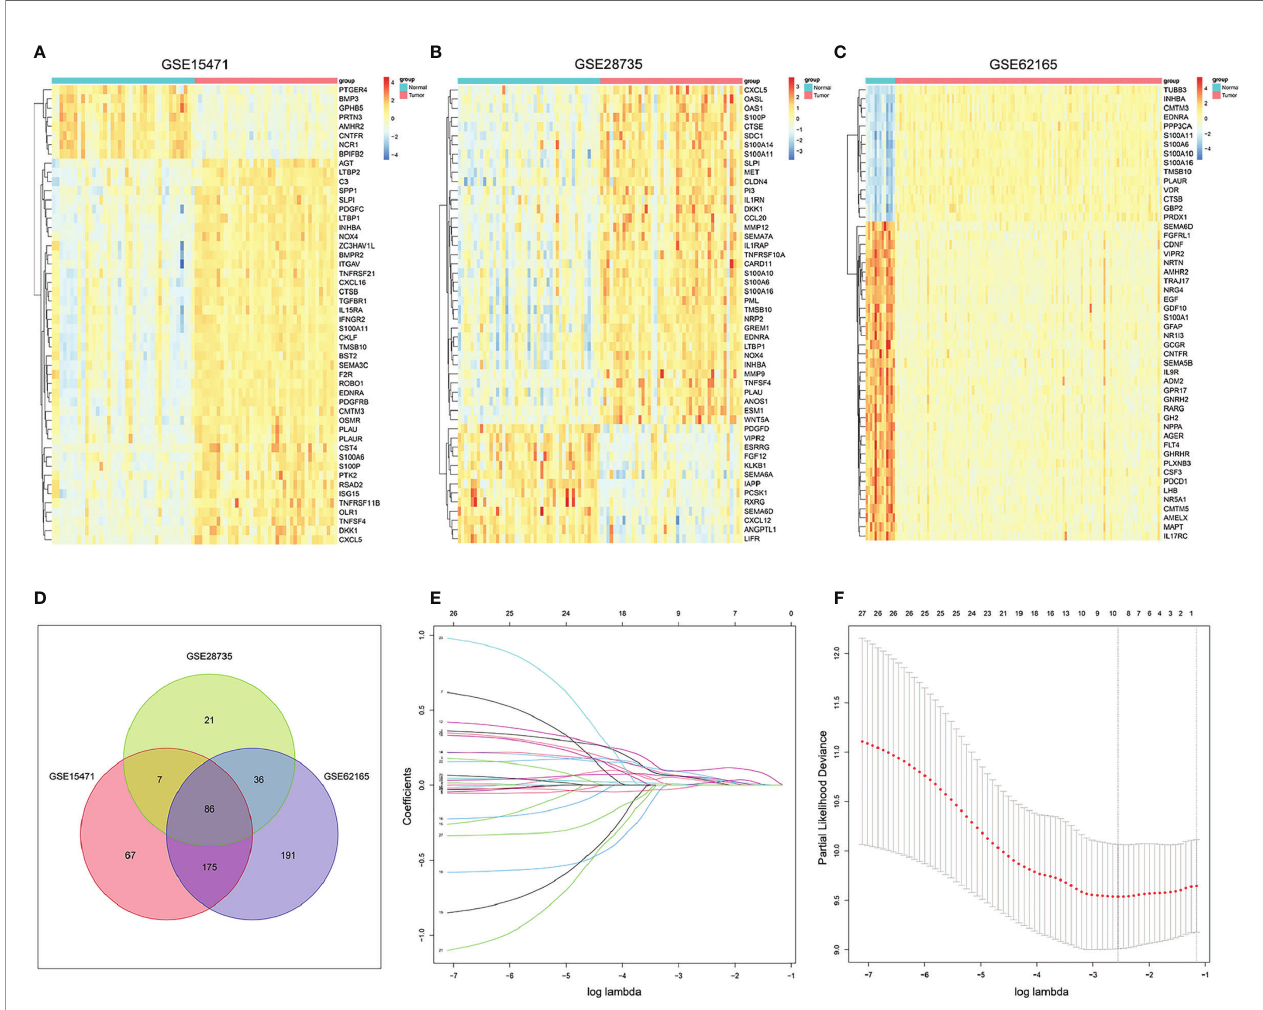
FIGURE 1 | Screening out immune-related genes for constructing a risk signature. (A – C) . Heatmap of immune-related DEGs between PC and normal tissue in GSE15471, GSE28735, and GSE62165. (D) Venn plot of the intersection of three DEGs dataset. (E) LASSO coef fi cient pro fi les of 27 prognostic IRGs. (F) Cross- validation for tuning parameter selection in the LASSO